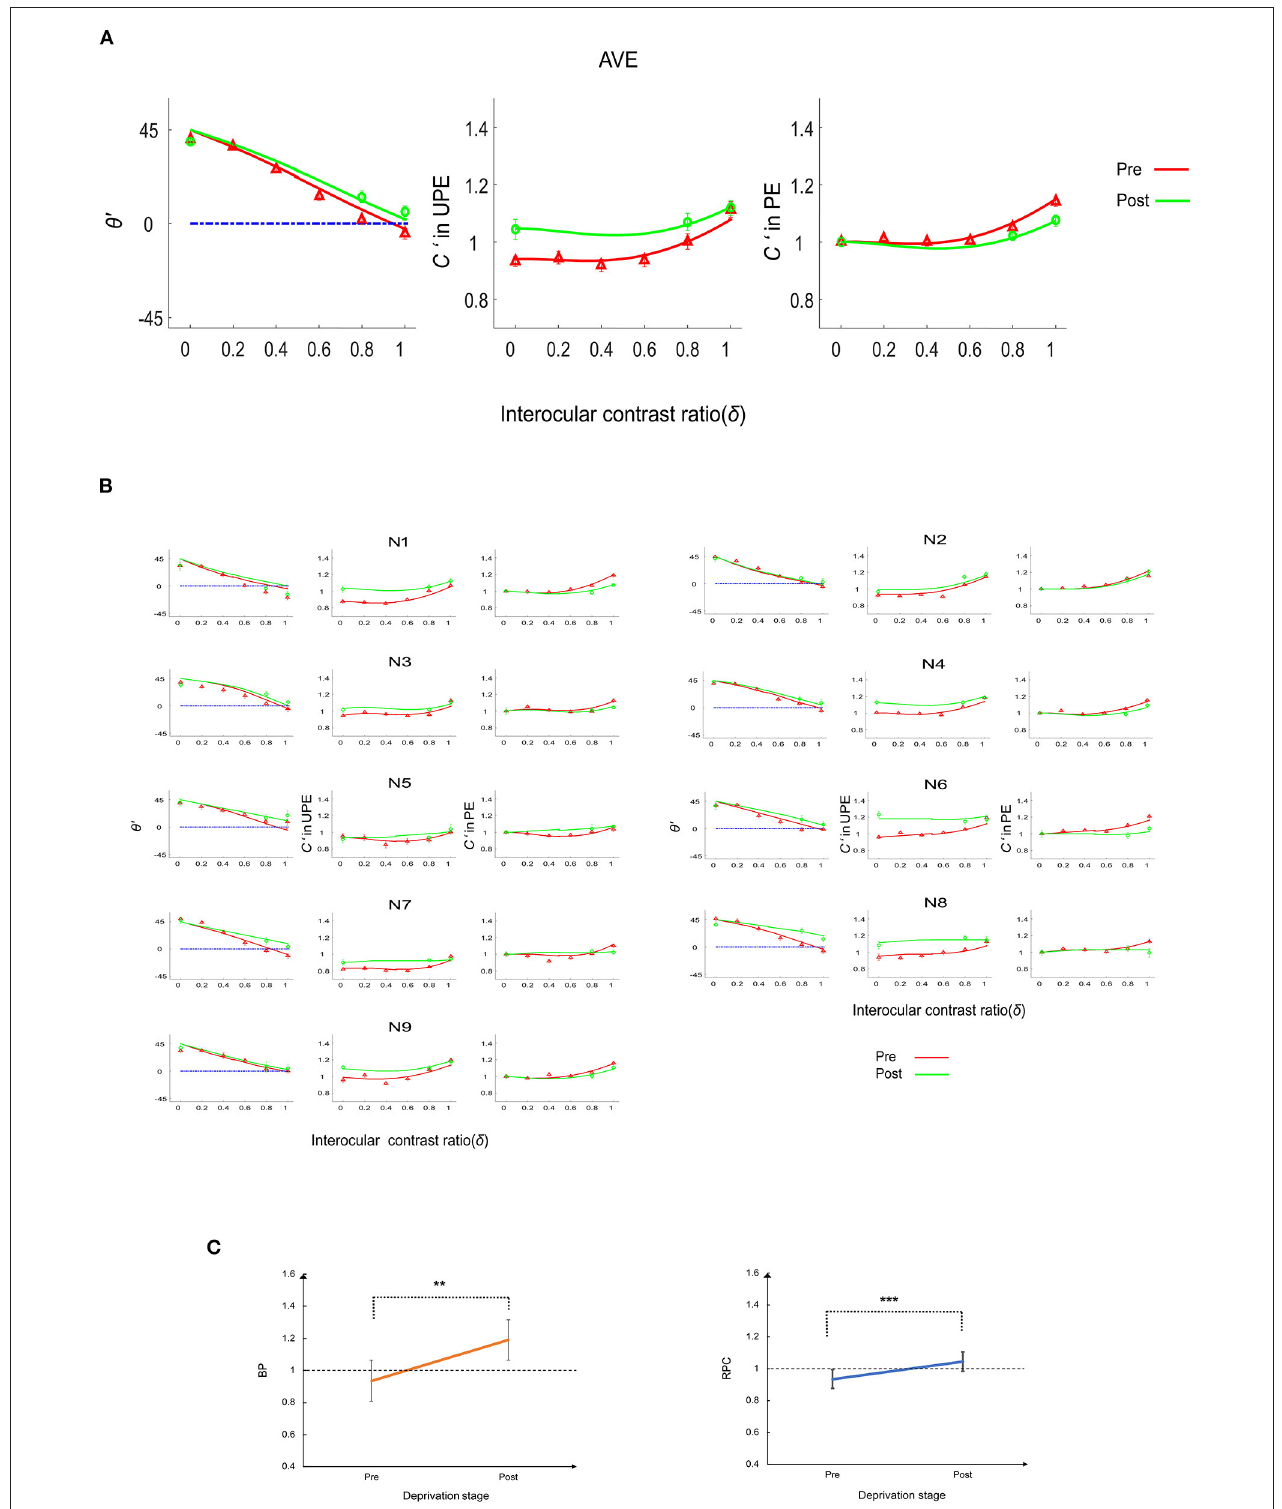
FIGURE 2 | The deprivation effect on the phase and contrast co-measurement tasks. (A) Perceived phase and contrast for the average (AVE) of nine subjects. The first column represents the perceived phase ( θ ’ ), the second column represents the perceived contrast ( C’ ) when the probe grating was displayed to the UPE, and the third column represents the perceived contrast when the probe grating was displayed to the PE. The solid lines (red and green) represent the model predictions. (B)